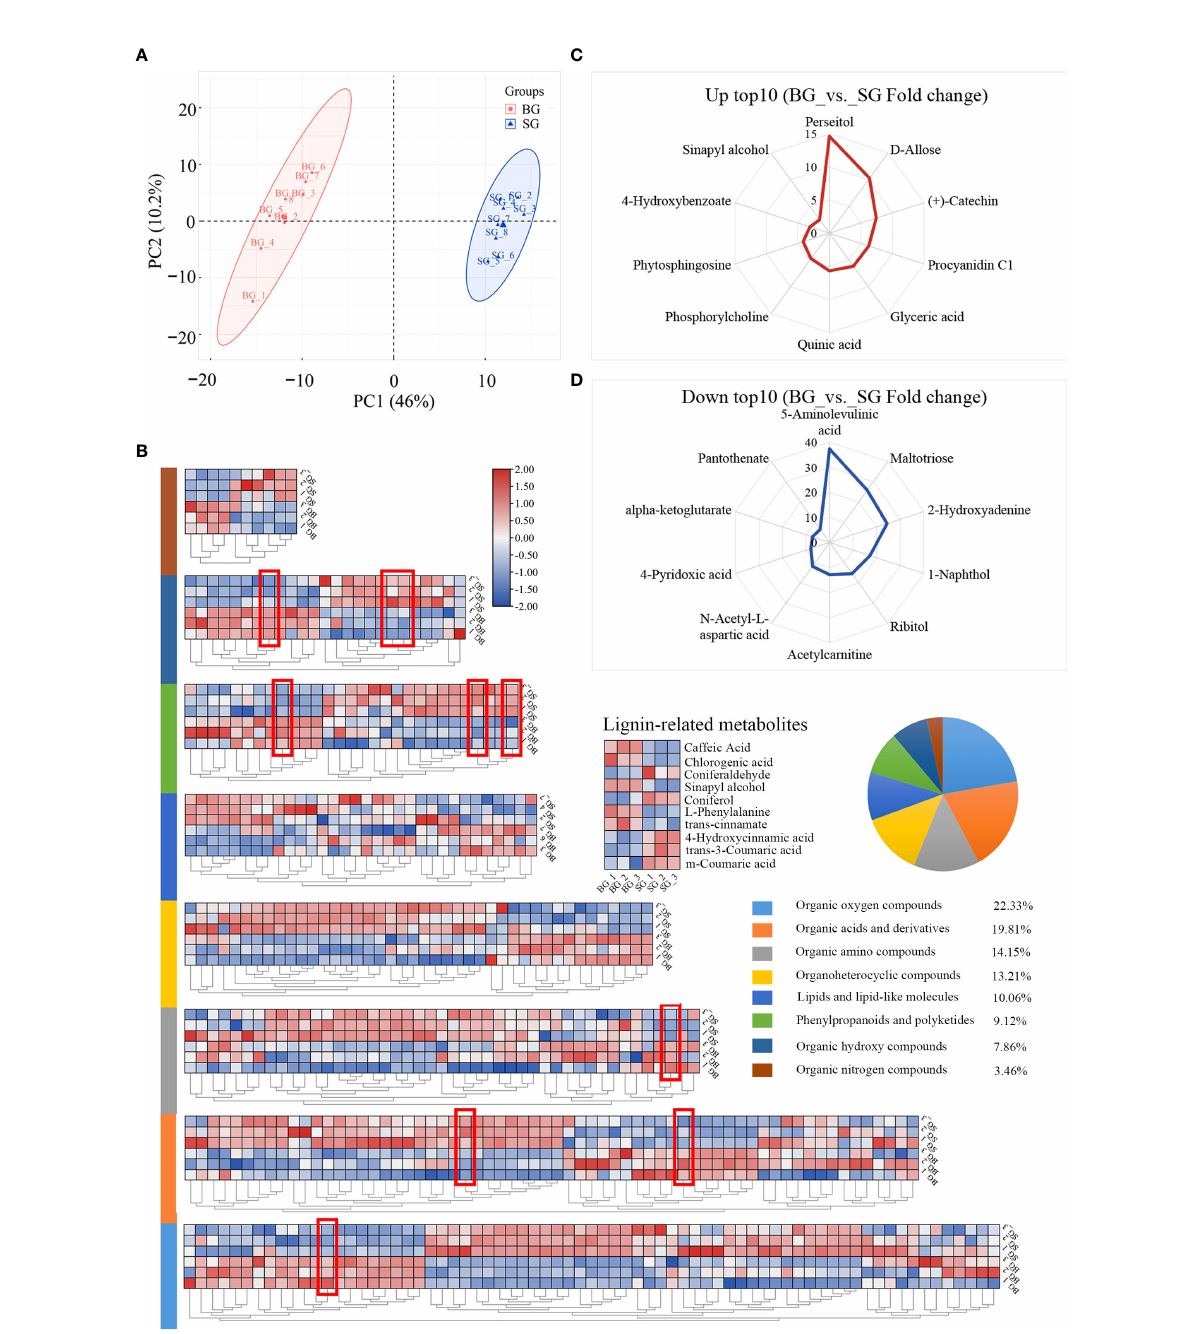
FIGURE 2 Component analysis of the identi fi ed metabolites based on UHPLC-Q-TOF MS. (A) Principal component analysis (PCA) showing all samples. (B) Heat map of the identi fi ed metabolite expression levels and pie chart showing the superclass of these metabolites between BG and SG. (C) Top 10 metabolites with upregulated expression in BG vs. SG. (D) Top 10 metabolites with upregulated expression in SG vs.